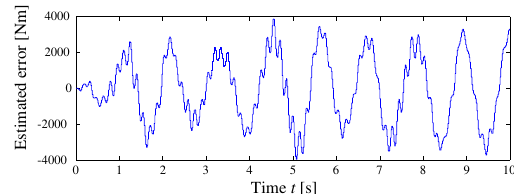
Figure 13. Estimated error of H ∞ observer at with white